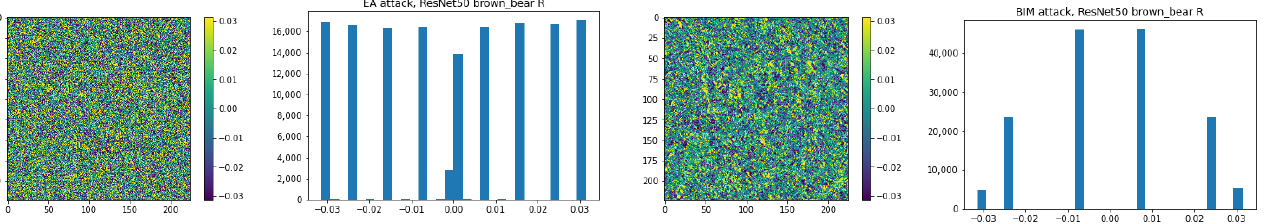
Figure 2. Display of the noise and histogram of the perturbations added by the EA ( left pair) and by BIM ( right pair) to the red channel of A 4